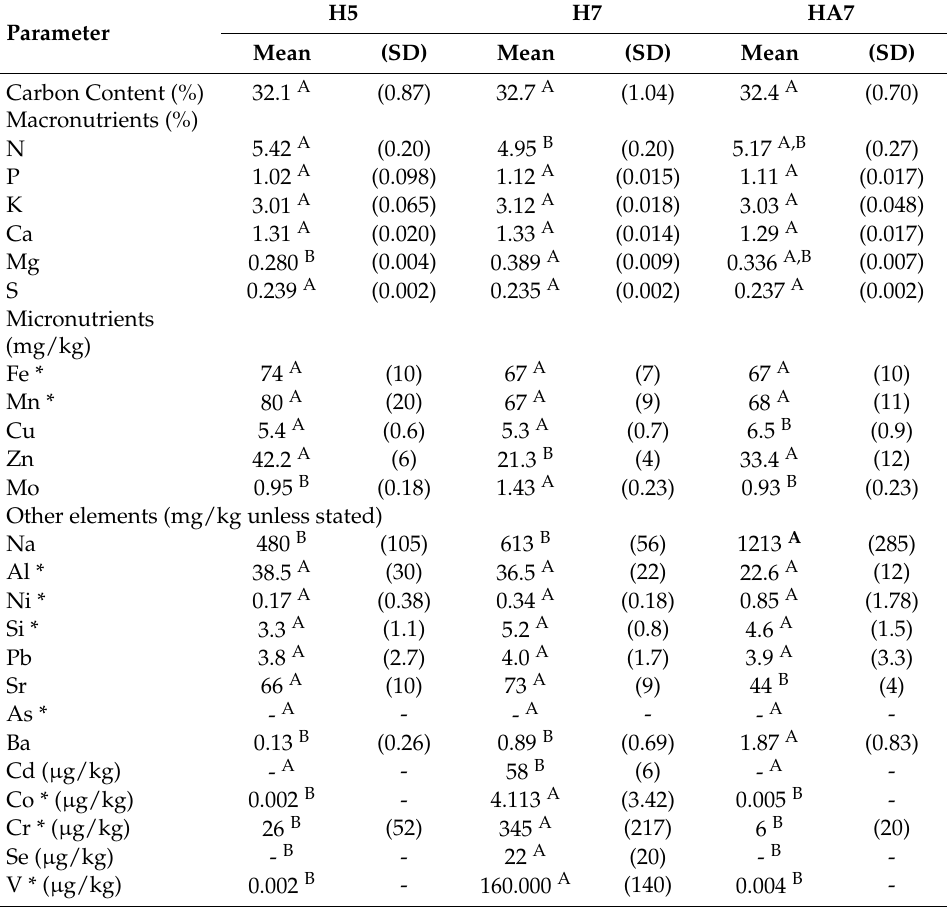
Table 7. Shoot tissue analysis mean, standard deviation (SD), and multi-model significance; all data is on dry weight basis and in mg/kg unless otherwise noted. Columns with differing superscript letters are significantly different at alpha =